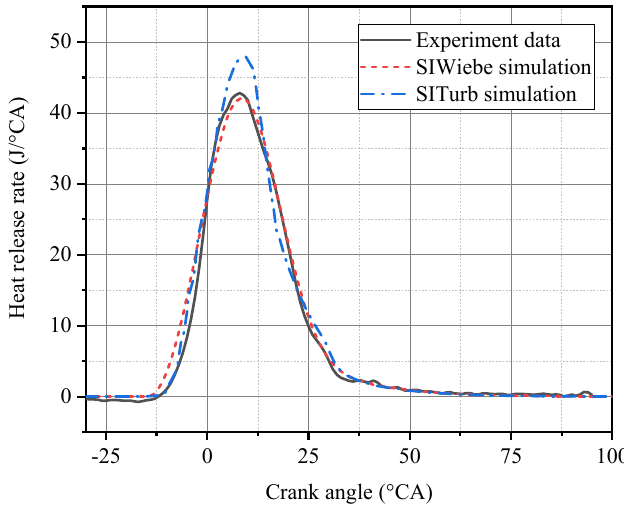
Figure 16. Heat release rate by simulation using SIWiebe and SITurb models in comparison of measured data by experiment (point of operation: n = 3000 rpm, BMEP = 10 bar, CA50 = 8 ◦ CA, intake advance angle = 25 ◦ CA, exhaust retardation angle = 5 ◦